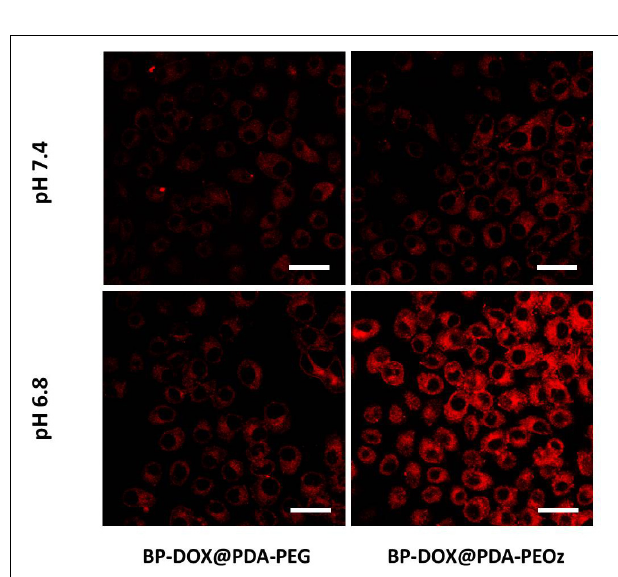
FIGURE 7 | Confocal laser scanning microscopy images of MCF-7 cells incubated with the solution of BP-DOX@PDA-PEG and BP-DOX@PDA-PEOz at different pH values after 4 h. DOX concentration: 10 µ g mL − 1 . Scale bar is 20 µ